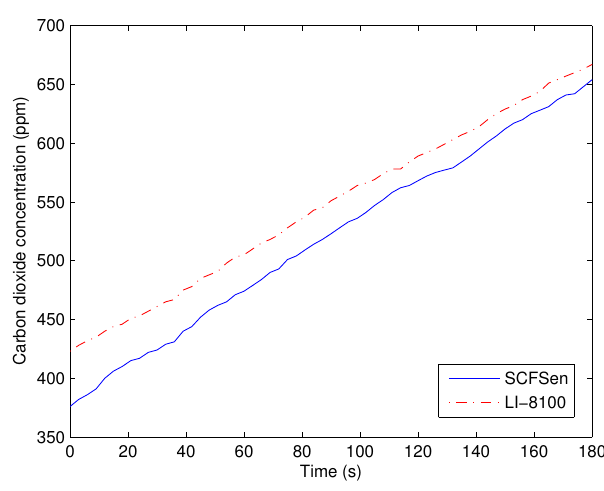
Figure 6. Changing of carbon dioxide